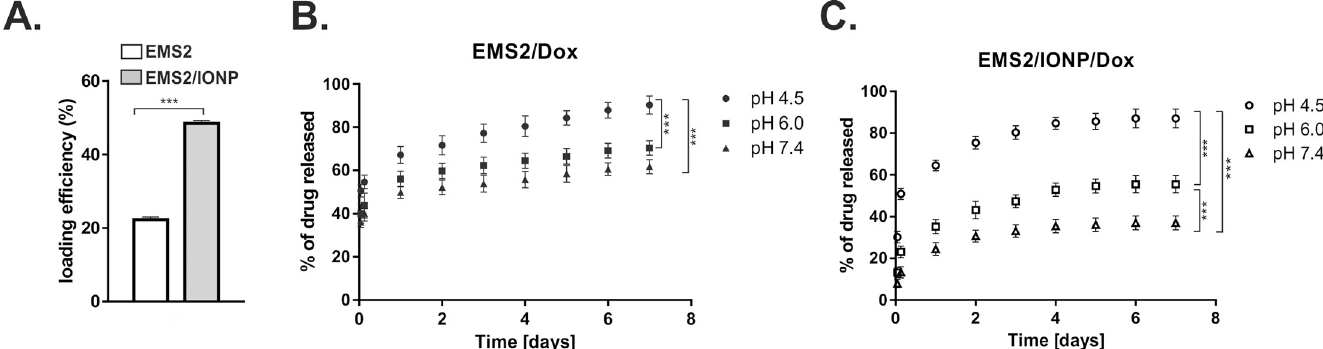
Fig 6. The loading efficiency and release kinetics of doxorubicin (Dox). A) Spheres were loaded with Dox using a post-loading method. B, C) From the B) EMS2 and C) EMS2/IONP spheres, doxorubicin was released at 37˚C in PBS buffers at pH values of 7.4, 6 and 4.5 over 7 days. The time points for the drug release measurements were after 1 and 3 h of incubation on day 1 and then every 24 h. The means and standard deviations of three independent experiments are shown. � indicates statistical significance with p < 0.0001; ��� indicates statistical significance with p < 0.001.